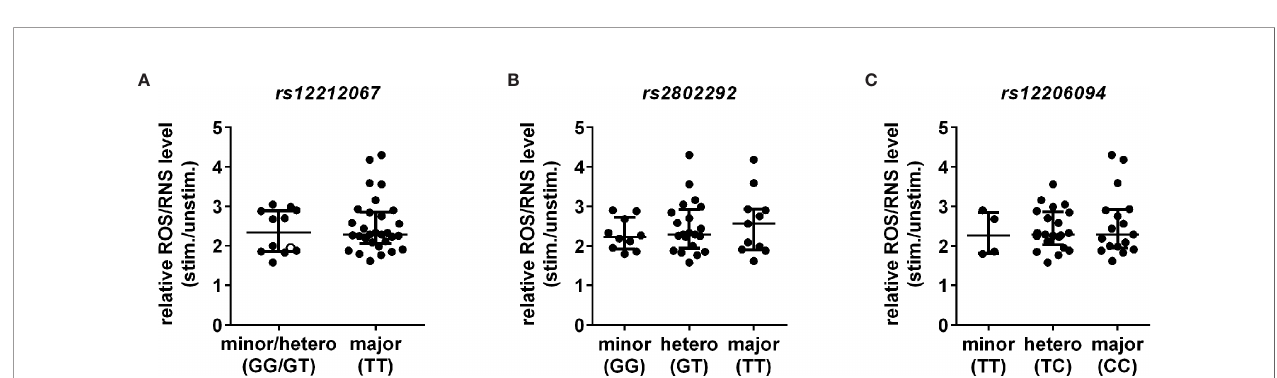
FIGURE 6 | FOXO3 gain-of-function SNPs have no in fl uence on ROS/RNS level. ROS/RNS level in CD14 + monocytes were investigated following stimulation with PMA [100 ng/ml] for 10 min by DCFH-DA staining using FC. (A) rs12212067 SNP carrier minor/heterozygous n=12 and major n=30. Minor allele carrier is depicted with an open circle ( ○ ). (B) rs2802292 SNP carrier minor n=10, heterozygous n=21 and major n=11 and (C) rs12206094 SNP carrier: minor n=4, heterozygous n=21 and major n=17. Median with interquartile range is depicted and Mann-Whitney test is used for statistical analysis between independent